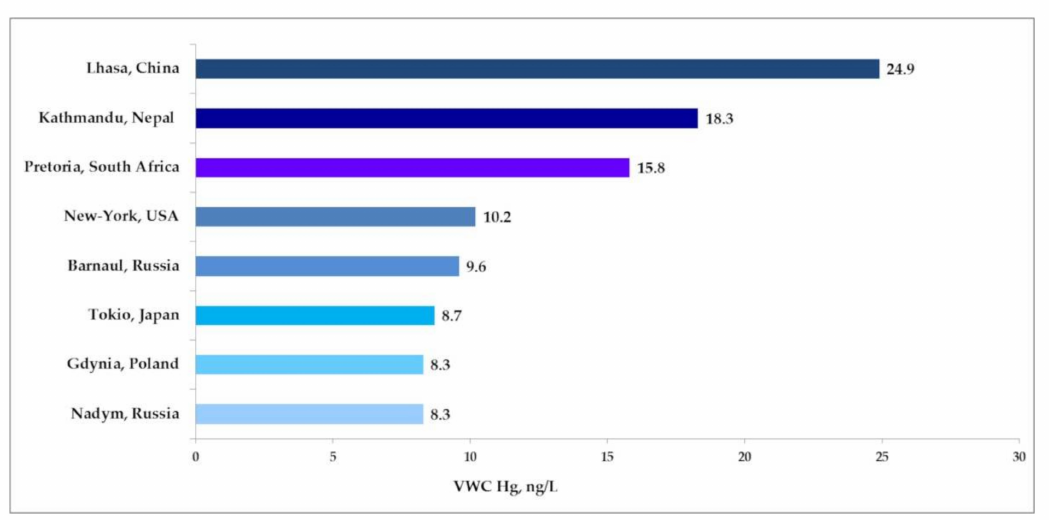
Figure 4. Annual volume-weighted concentrations of Hg in wet precipitation in various urbanized areas, ng/L (the intensity of the colour is proportional to the Hg